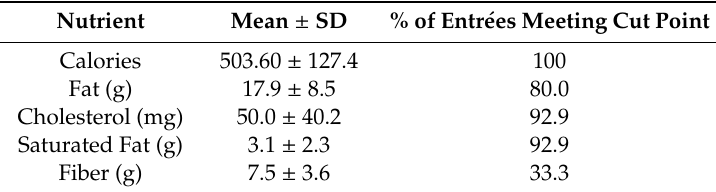
Table 1. Calorie and nutrient content of entr é es listed as healthier options on the adult menu at a regional restaurant chain.